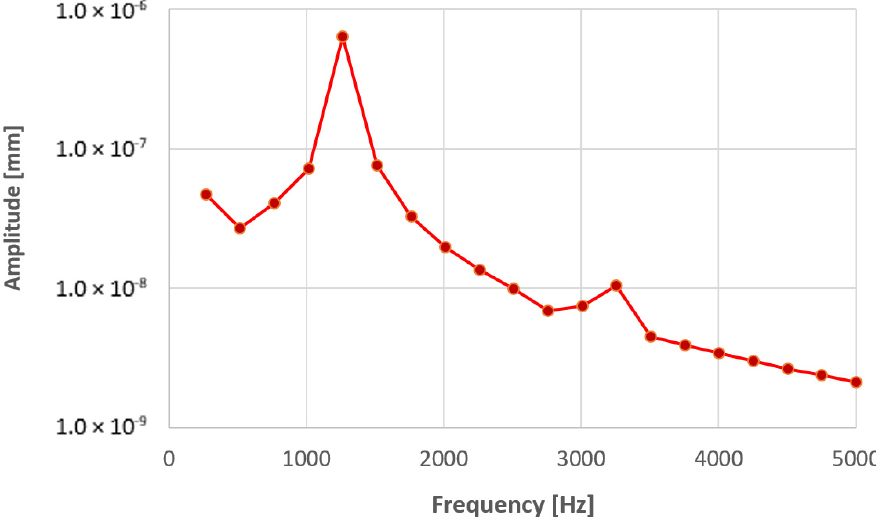
Figure 11. Radial harmonic response of the wheel.